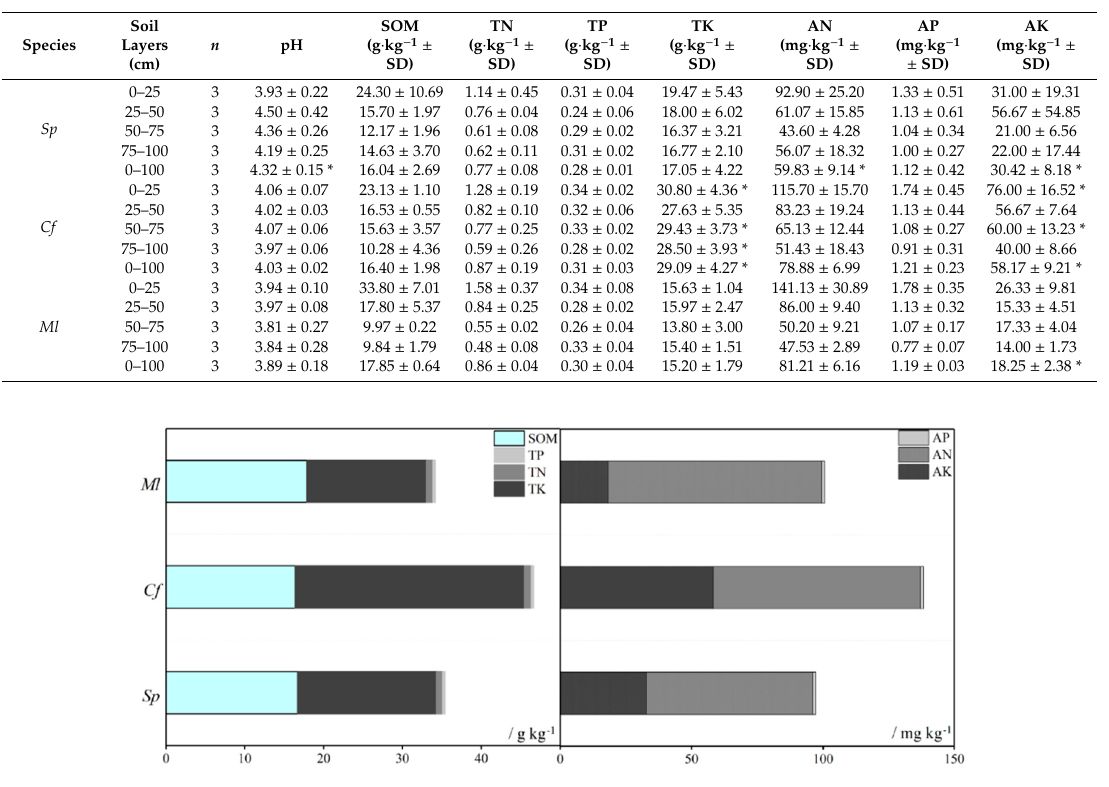
Figure 3. Soil chemical variables including SOM (g · kg − 1 ), TN (g · kg − 1 ), TP (g · kg − 1 ), TK (g · kg − 1 ), AN (mg · kg − 1 ), AP (mg · kg − 1 ) and AK (mg · kg − 1 ) for the three tree species in the overall 0–100 cm layer.